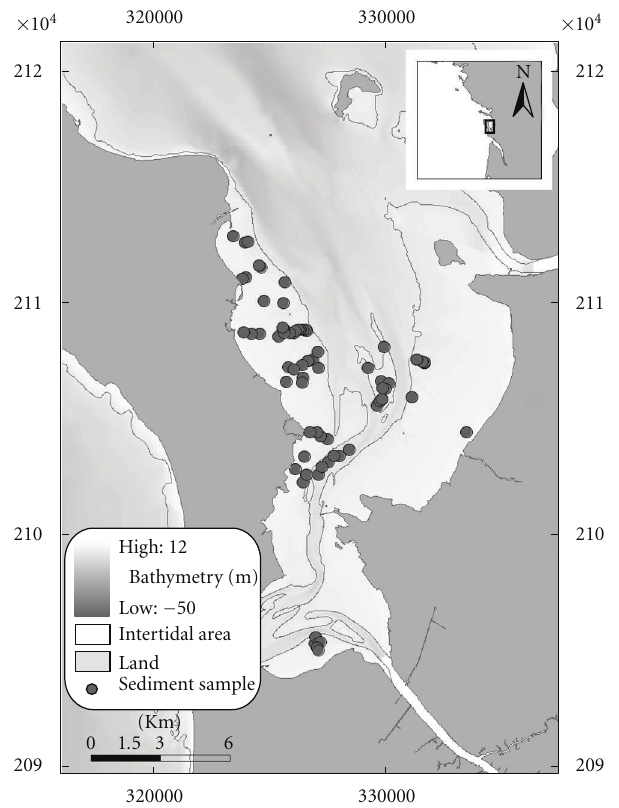
Figure 1: Location of studied areas in the Marennes Ol´eron